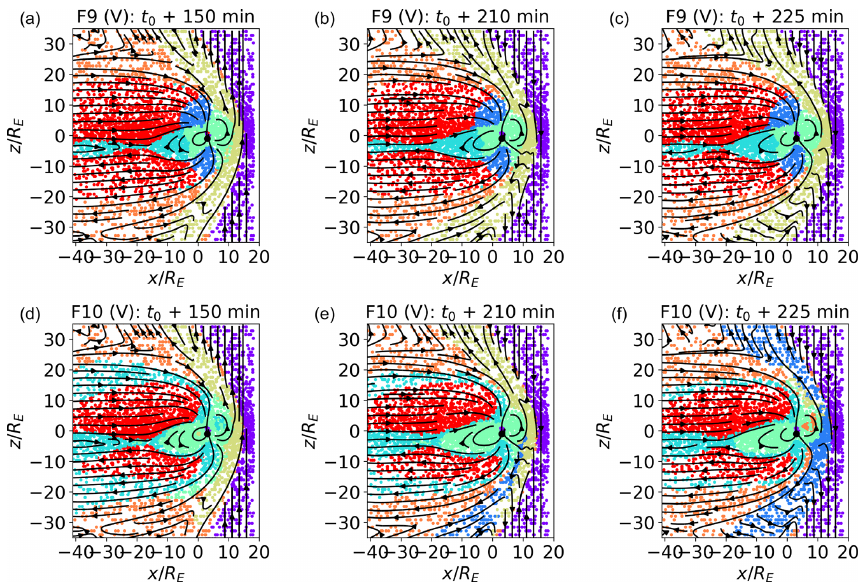
Figure 10. Classification of validation data sets. y/R E = 0 plane at t 0 + 150, 210, and 225min for maps trained with the F9 and F10 feature sets. In F9 and F10, the module of the magnetic field, instead of its components, is used. In F9, | B | is clipped, as described in Sect. 4. In F10, the logarithm of the module of the magnetic field is